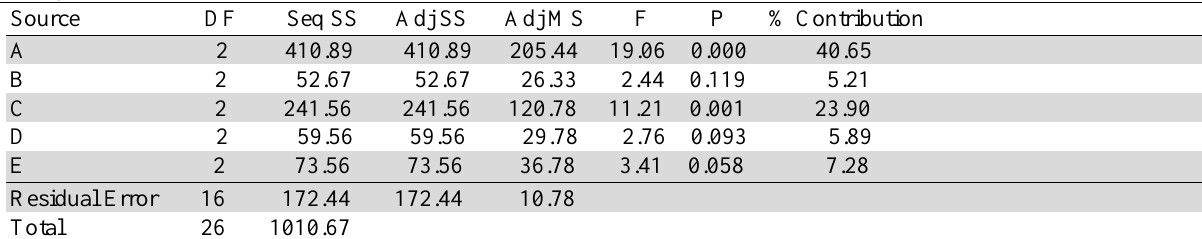
Analysis of variance for Means